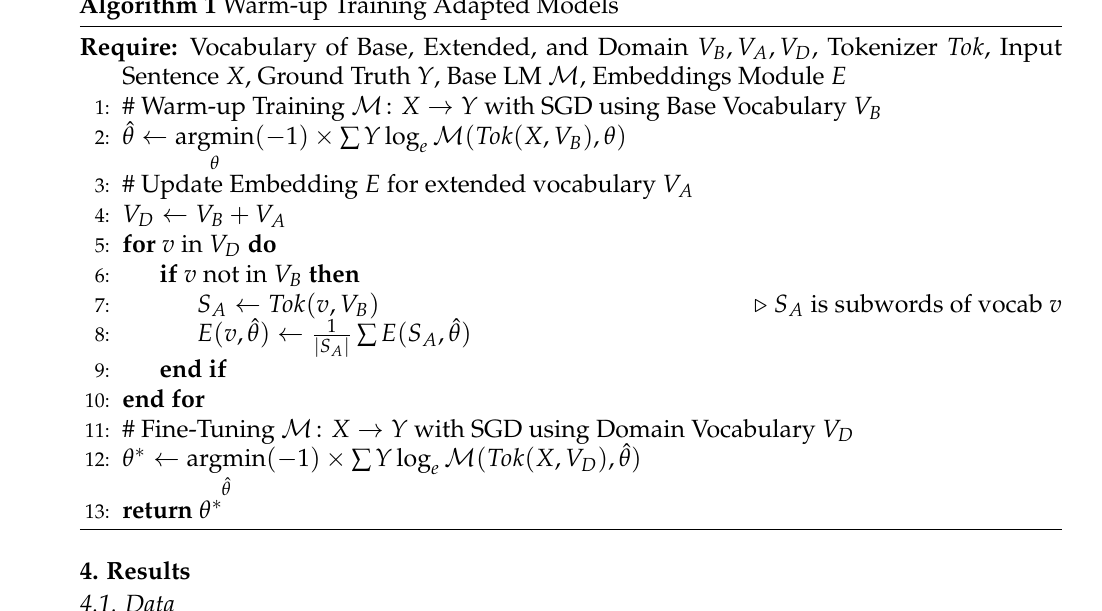
Algorithm 1 Warm-up Training Adapted